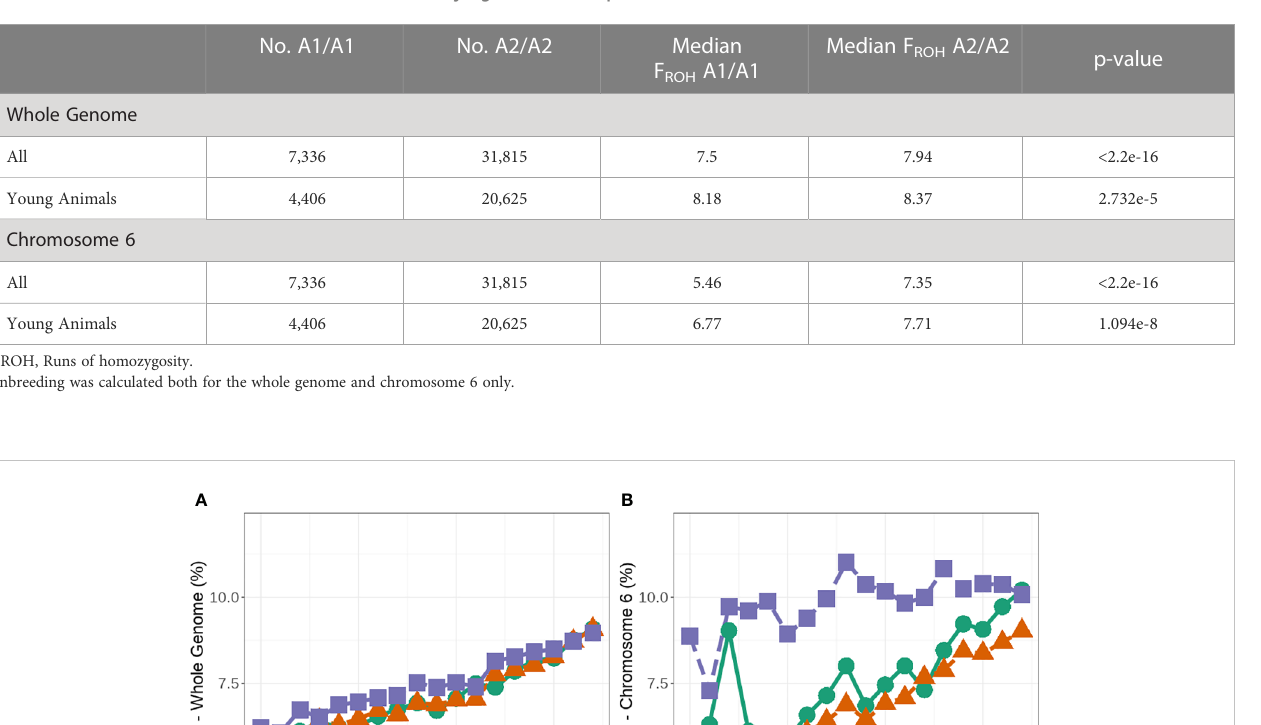
TABLE 3 The median genomic inbreeding values (F ROH* ) for all cows (born in 2000-2017) or young animals (born in 2013-2017) homozygous for the b -casein A1 or A2 allele and the Wilcoxon-Mann Whitney signi fi cance test p-values.